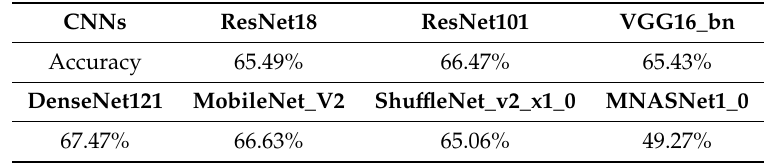
Table 4. Comparison of the overall classification accuracy of di ff erent models. The convolution mapping method was adopted.